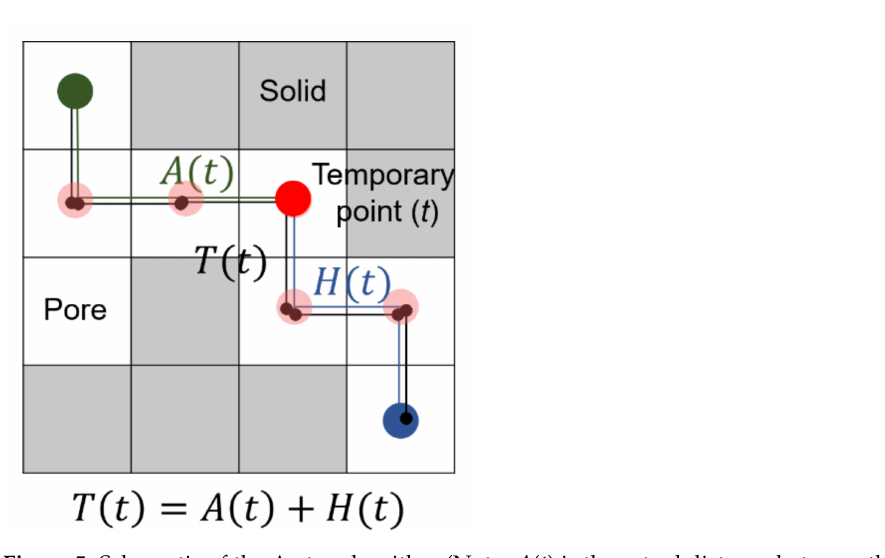
Figure 5. Schematic of the A-star algorithm (Note: A ( t ) is the actual distance between the starting point and a temporary point, and H ( t ) represents the heuristic path between the temporary and the end points at an iteration t . The total cost ( T ( t )) can be obtained by combining the actual and heuristic paths.).